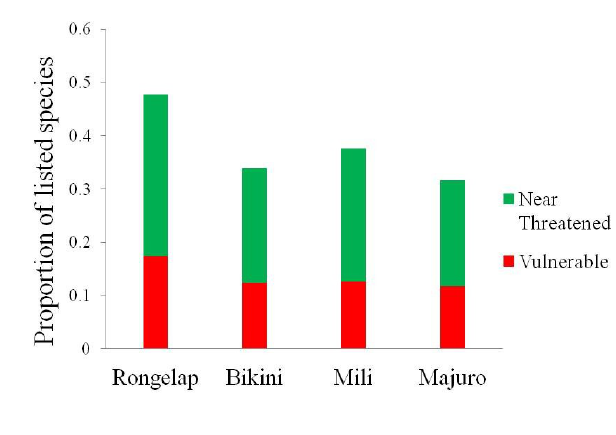
Figure 7. Proportion of Near Threatened and Vulnerable coral species per atoll (global scale) based on estimated total species number (n = 14 sites). Ailinginae and Rongerik were omitted due to the low number of surveyed